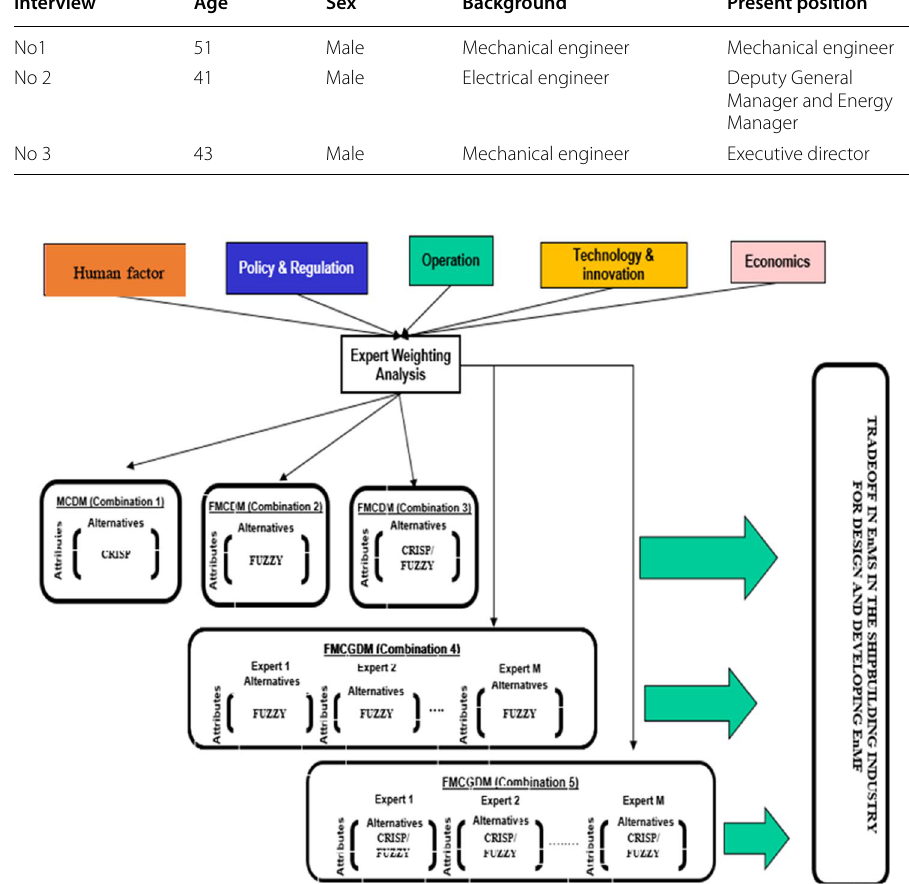
Fig. 7 Proposed decision making framework for evaluating trade-off solutions. Source : Adapted from (Ölçer and Ballini